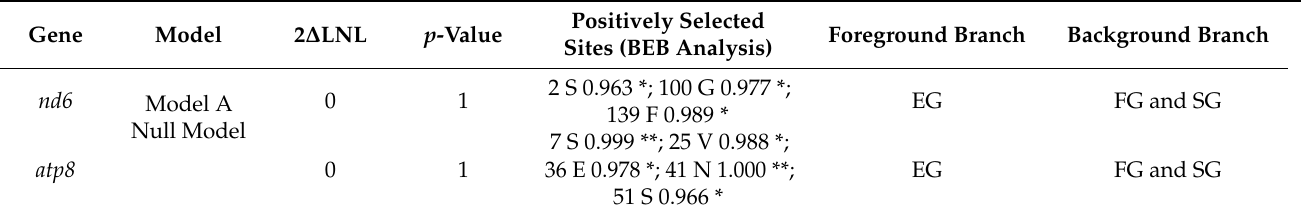
Table 6. Positive selection for 13 mtDNA PCGs in the freshwater, seawater, and euryhaline groups based on the branch-site